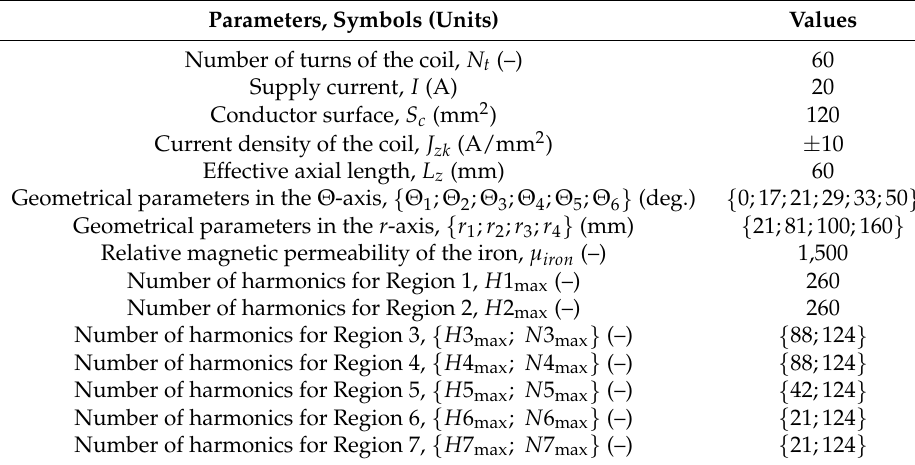
Table 1. Physical and geometrical parameters of the air- or iron-cored coil. Parameters, Symbols (Units) Values Number of turns of the coil, N t (–) 60 Supply current, I (A) 20 Conductor surface, S c (mm 2 ) 120 Current density of the coil, J zk (A/mm 2 ) ± 10 Effective axial length, L z (mm) 60 Geometrical parameters in the Θ -axis, { Θ 1 ; Θ 2 ; Θ 3 ; Θ 4 ; Θ 5 ; Θ 6 } (deg.) { 0;17;21;29;33;50 } Geometrical parameters in the r -axis, { r 1 ; r 2 ; r 3 ; r 4 } (mm) { 21;81;100;160 } Relative magnetic permeability of the iron, µ iron (–) 1,500 Number of harmonics for Region 1, H 1 max (–) 260 Number of harmonics for Region 2, H 2 max (–) 260 Number of harmonics for Region 3, { H 3 max ; N 3 max } (–) { 88;124 } Number of harmonics for Region 4, { H 4 max ; N 4 max } (–) { 88;124 } Number of harmonics for Region 5, { H 5 max ; N 5 max } (–) { 42;124 } Number of harmonics for Region 6, { H 6 max ; N 6 max } (–) { 21;124 } Number of harmonics for Region 7, { H 7 max ; N 7 max } (–) { 21;124